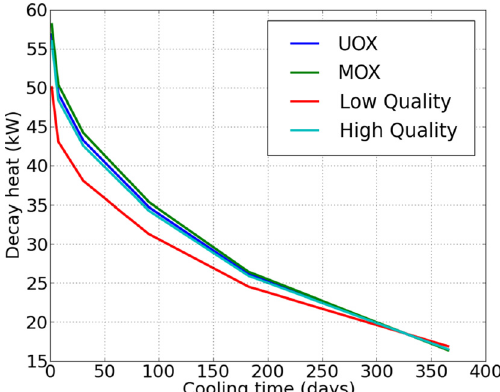
Fig. 6. Comparison of the short term decay heat per assembly for each of the initial americium